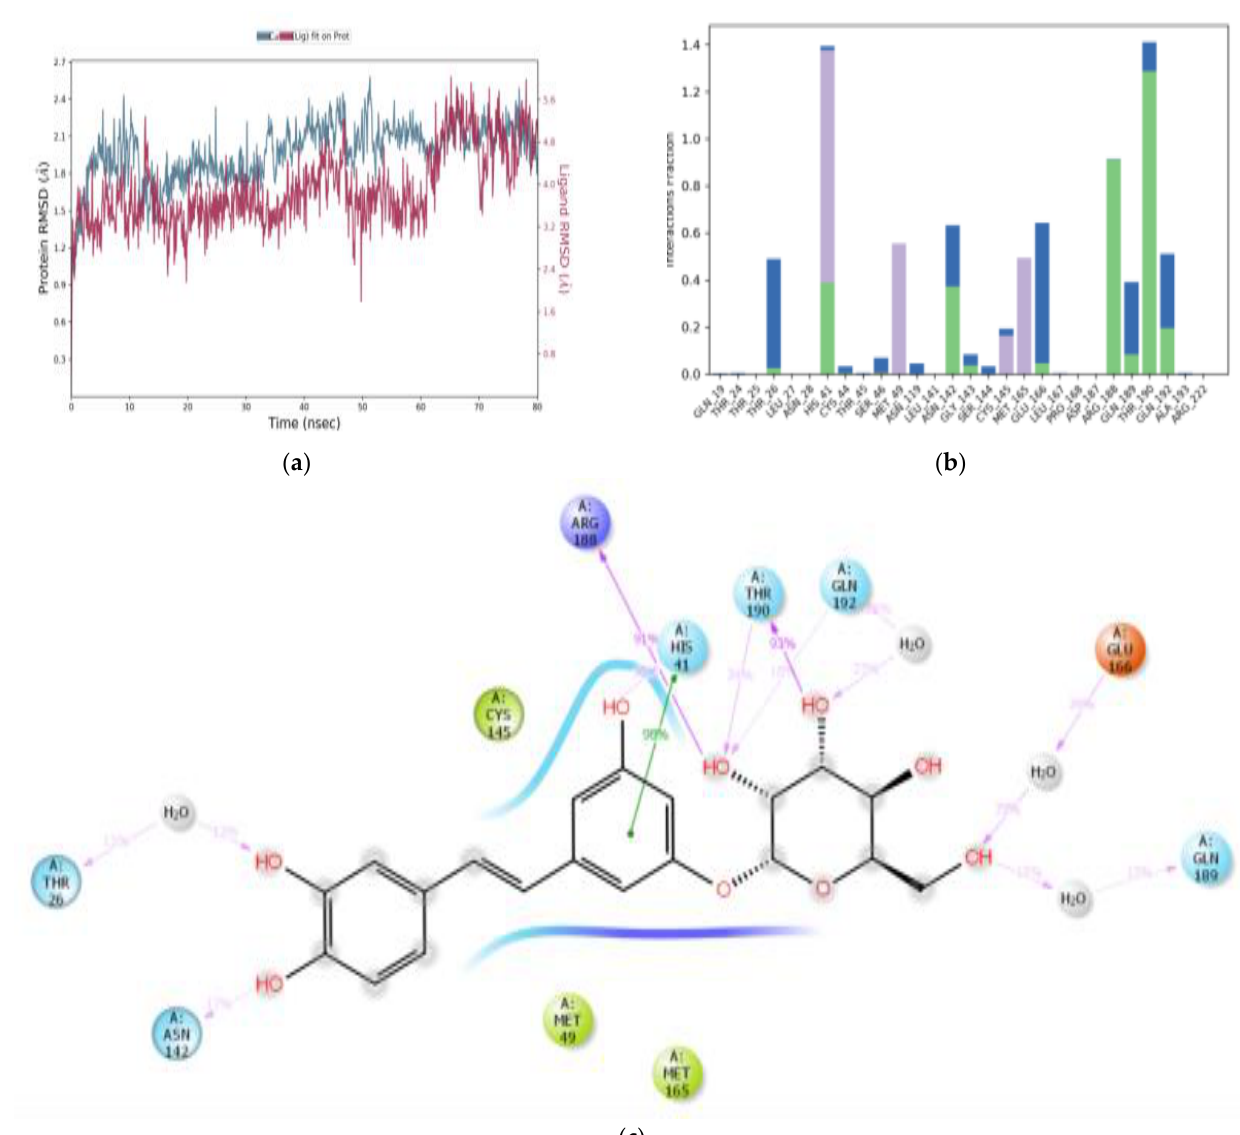
Figure 6. MD simulation studies of isorhapontin (Structure 2) in complex with M pro . RMSD plot of protein backbone (Cα) and protein conformational change during ligand binding ( a ). Interaction fraction plot showing different protein residues that interact with isorhapontin during a 100 ns MD simulation ( b ). Interaction of ligand atoms with the protein residues that occurs for >70% of the simulation time ( c ).